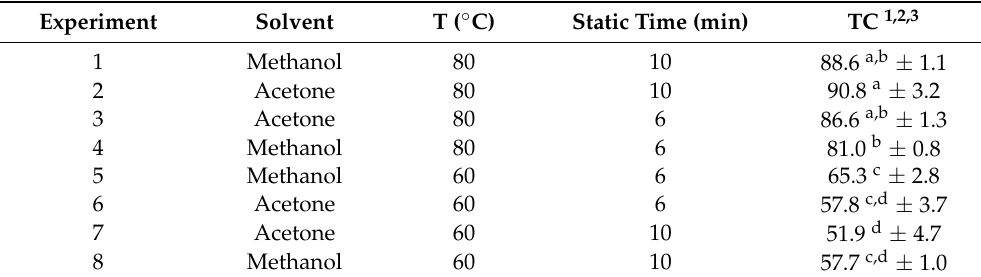
Table 1. UPLC-DAD quantification of total curcuminoids in turmeric sample NR-1 under various PLE